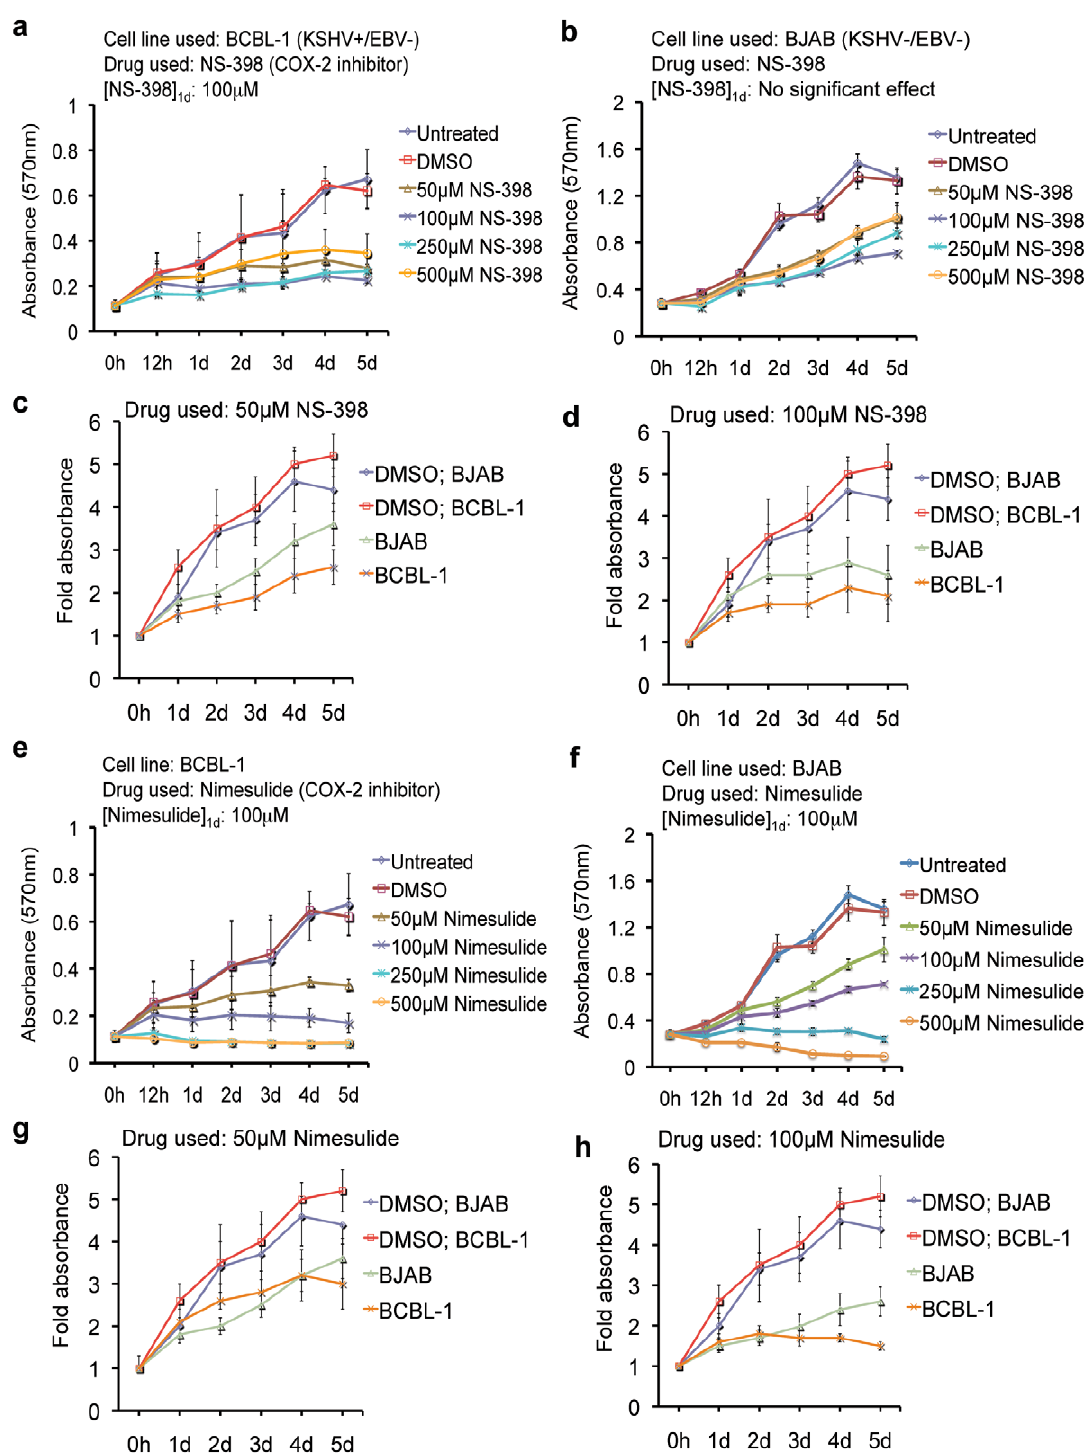
Figure 1. Sensitivity of KSHV + PEL cells to COX-2 specific inhibitors. ( a–h ) 5 6 10 5 BCBL-1 or BJAB cells were seeded with the indicated concentrations of COX-2 inhibitors NS-398 ( a–d ), nimesulide ( e–h ), DMSO ( a–h ) or left untreated ( a–h ). Cell proliferation was measured by MTT assay at 0 h, 12 h, day 1 (1d), day 2 (2d), day 3 (3d), day 4 (4d), and day 5 (5d). The cells were neither replenished with fresh media nor supplemented with the drugs. ( c, d, g, h ) Plots comparing the proliferation rate of BCBL-1 and BJAB cells treated with 50 m M and 100 m M of NS-398 and nimesulide 0 h, 1d, 2d, 3d, 4d, and 5d post-treatment. The fold absorbance was calculated with respect to the untreated (UN) control before treatment. ( a–h ) One- way ANOVA with Tukey’s posthoc comparison analysis (p , 0.05) was used to determine whether the drug treatment induced a statistically significant difference in the proliferative indexes at 1d, 2d, 3d, 4d and 5d compared to untreated cells of the respective cell lines. Indicated on the graphs are the concentrations of each drug that had a significant effect at 1d ([drug] 1d ). Each reaction was done in quadruplicate, and each point represents the average 6 S.D. from four independent experiments.